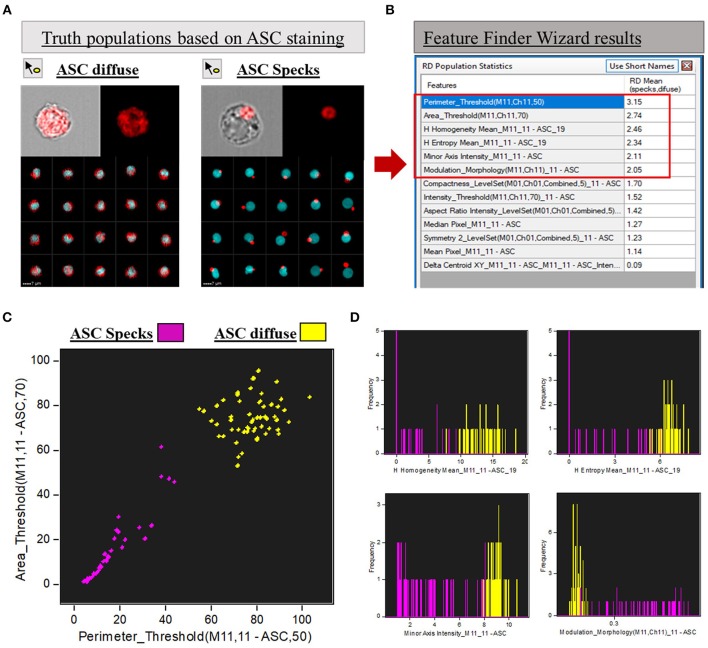
Feature Finder Wizard results for ASC speck discrimination. (A) Representative imagery in the gallery area of Diffuse vs. ASC speck phenotypes assigned as “truth populations” for Feature Finder screening. (B) “Feature Finder Wizard Results” table of contents ranking the top 13 positions for speck discrimination. Red square highlighted the Top 6 positions due to Rd scores higher than 2. (C) Representative Dot-plot of the top 2 features suggested by Feature Finder: Area_Threshould(M11,11-ASC70) vs. Perimeter_Threshould(M11,11-ASC,50) showing the separation of the tow assigned “truth populations.” (D) Histograms of the “truth populations” according with the other ranking Features that achieved Rd scores higher than 2, as follows: H Homogeneity Mean_M11,11-ASC19, H Entropy Mean_M11,11-ASC19, Minor Axis Intensity_M11,11-ASC, Modulation_Morphology(M11,Ch11)_11-ASC.